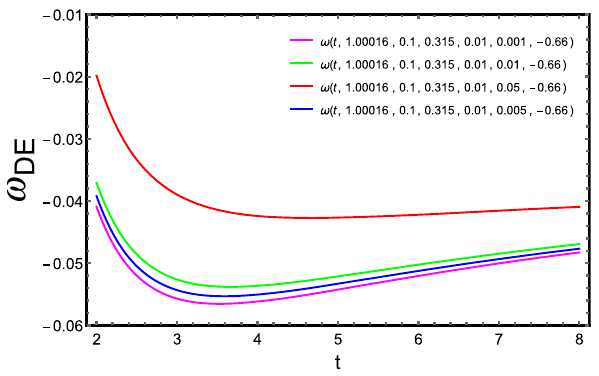
Fig. 4 DE EoS parameter vs. time for different α with (cid:12) = − 0 . 66